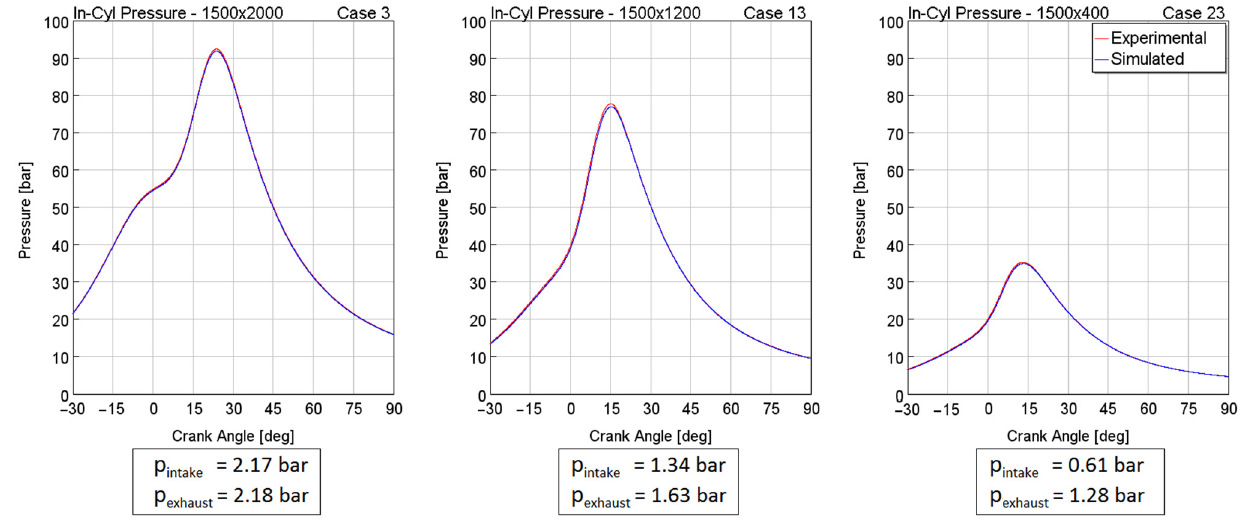
Figure 7. Comparison of in-cylinder pressure under three operating conditions at high, medium and low load. Intake and exhaust pressure data are shown in the box at the bottom of the figure for each condition tested.